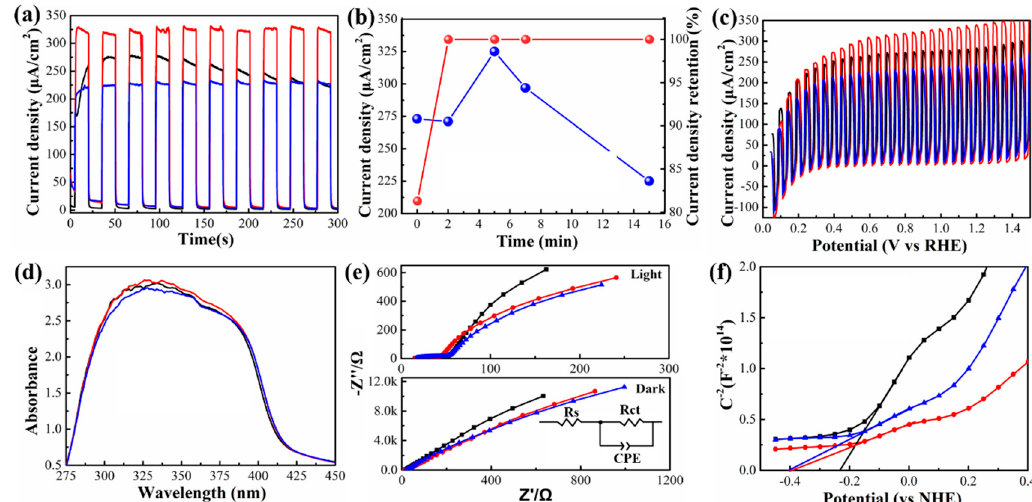
Figure 3. ( a ) Transient photocurrent density of TiO 2 /ZnSe NR photoanodes with atomic sulfur passivation for 0 min (black), 5 min (red), and 15 min (blue). ( b ) Dependence of the photocurrent density (blue) and photocurrent density retention (red) of TiO 2 / ZnSe NR photoanodes on the duration of the atomic sulfur passivation (data points are at 0, 2, 5, 7, and 15 min). ( c ) Light-chopped linear sweep voltammetry curves, ( d ) UV-vis absorption spectra, ( e ) electrochemical impedance spectroscopy curves under one sun illumination (AM 1.5 G) (inset: the equivalent circuit) and in the dark condition, and ( f ) Mott–Schottky plots of TiO 2 / ZnSe NR photoanodes passivated for 0 min (black), 5 min (red), and 15 min (blue). The intercepts of the Mott–Schottky plots represent the flat band potential of the photoanodes.